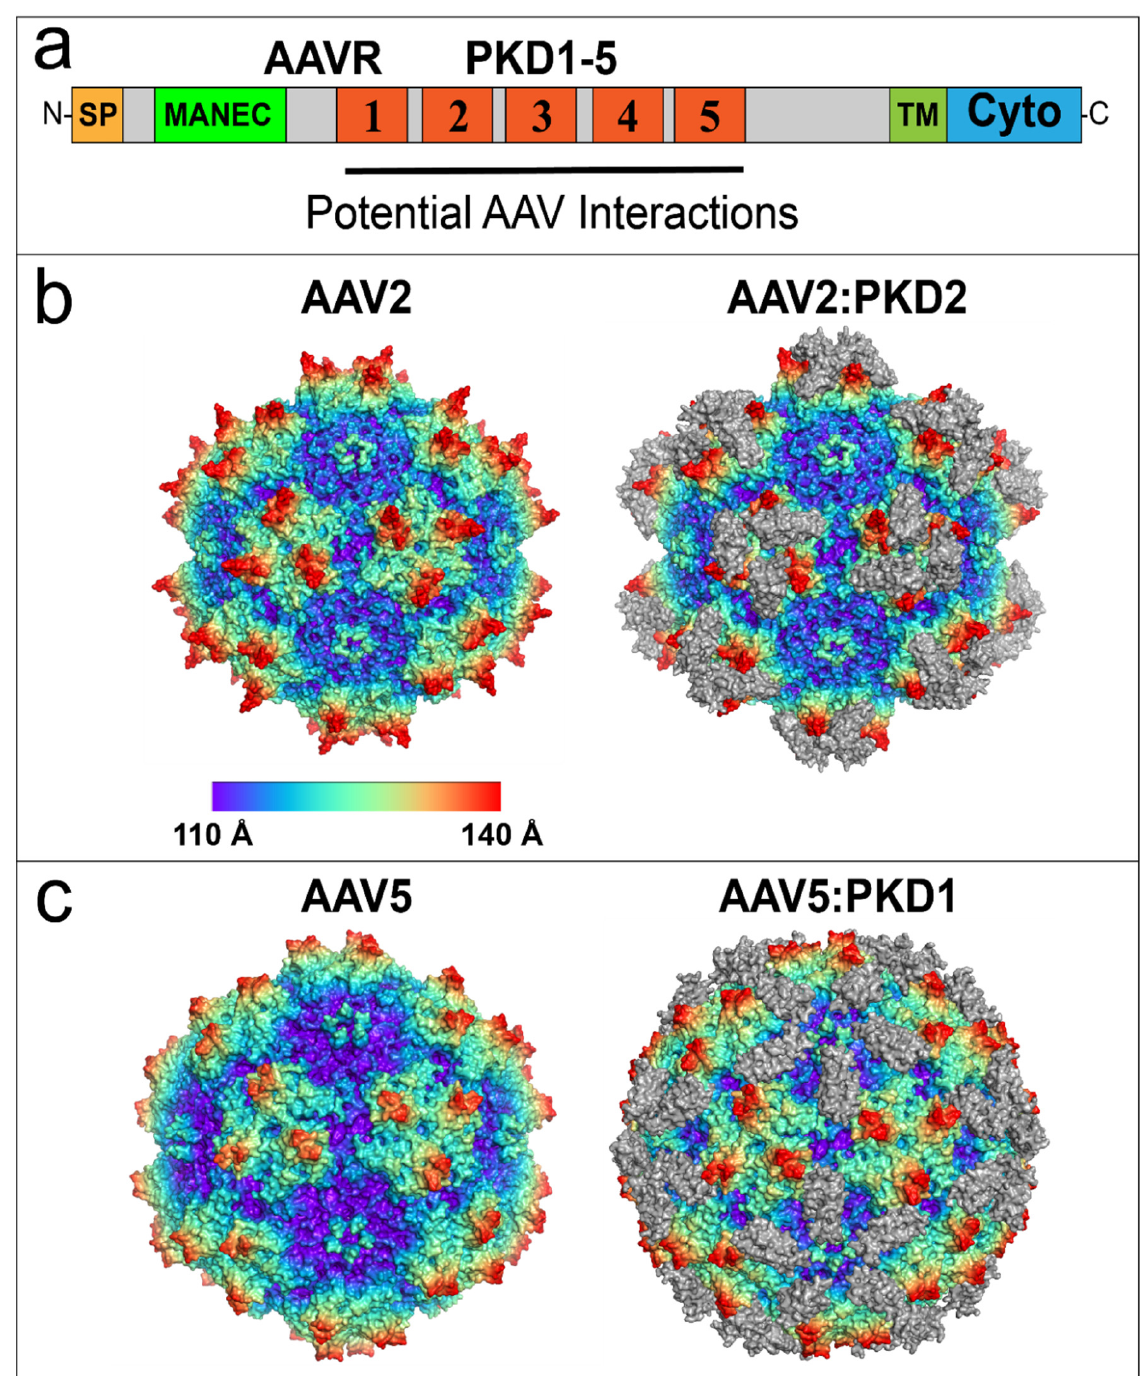
Figure 4. AAV2 and AAV5 bind to distinct AAVR PKD domains. ( a ) AAVR domain structure from N-terminus (N) to C- terminus (C): Signal Peptide (SP), Motif At the N-terminus with Eight Cysteines (MANEC), immunoglobulin-like Polycystic Kidney Disease (PKD) domains 1–5, TransMembrane (TM) helix and Cytoplasmic domain (Cyto). The region containing potential AAV interactions is composed of PKD1-5. ( b ) Native AAV2 60-mer (left) and the AAV2:PKD2 complex (right). Virus models are colored by radial distance from the center of the virion. The PKD2 domain of AAVR is colored in gray. ( c ) Virus model of native AAV5 virion (left) and the AAV5:PKD1 complex (right). Models are colored by radial distance from the center of the virion. The PKD1 domain of AAVR is colored in gray. Structures in ( b ) and ( c ) were prepared using PyMOL [66] .